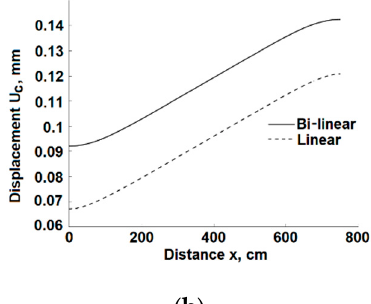
Figure 11. Slip and stresses distributions after first crack formation (P = 20.84 kN). ( a ) bond stress; ( b ) slip; ( c ) concrete stress; ( d ) rebar stress.